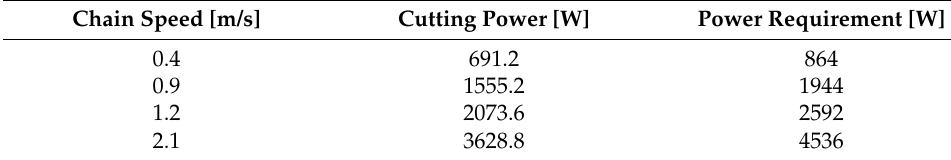
Table 2. Cutting forces and cutting powers. The chip area is a constant A chip = 6 mm 2 .